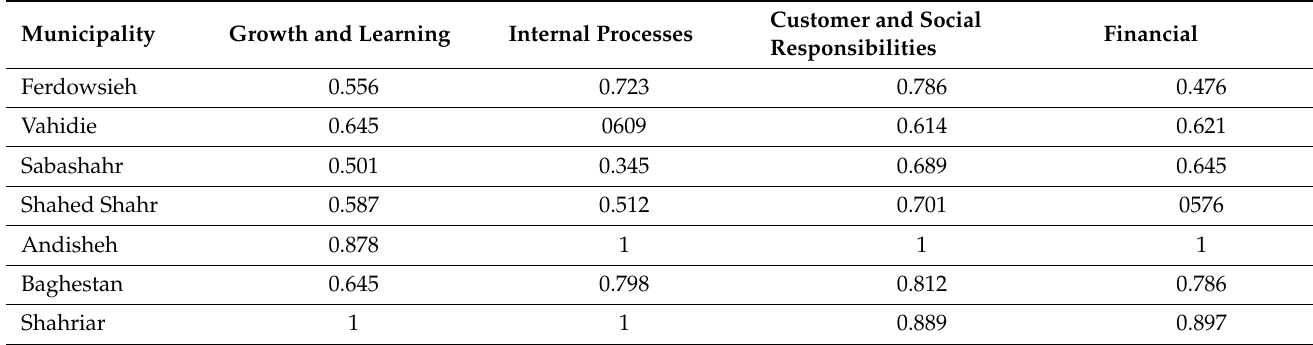
Table 8. Serial evaluation results.